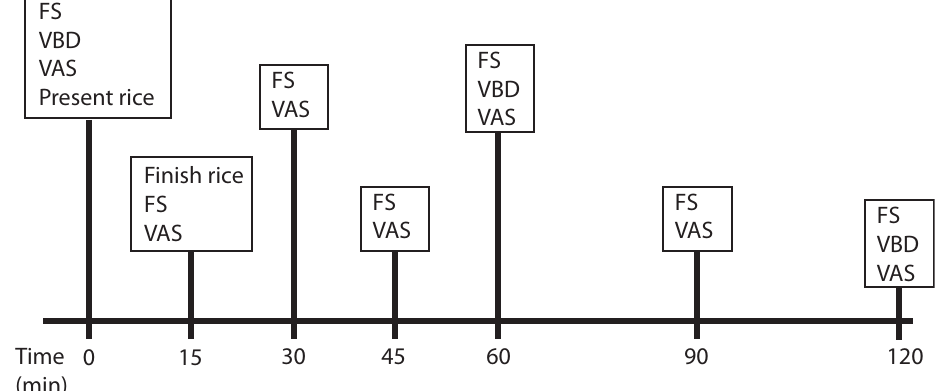
Figure 2. Timeline of the study visits. Abbreviations: FS, Finger stick blood draw for capillary glucose measurement; VBD, venous blood draw for glucose and insulin measurement; VAS, visual analog